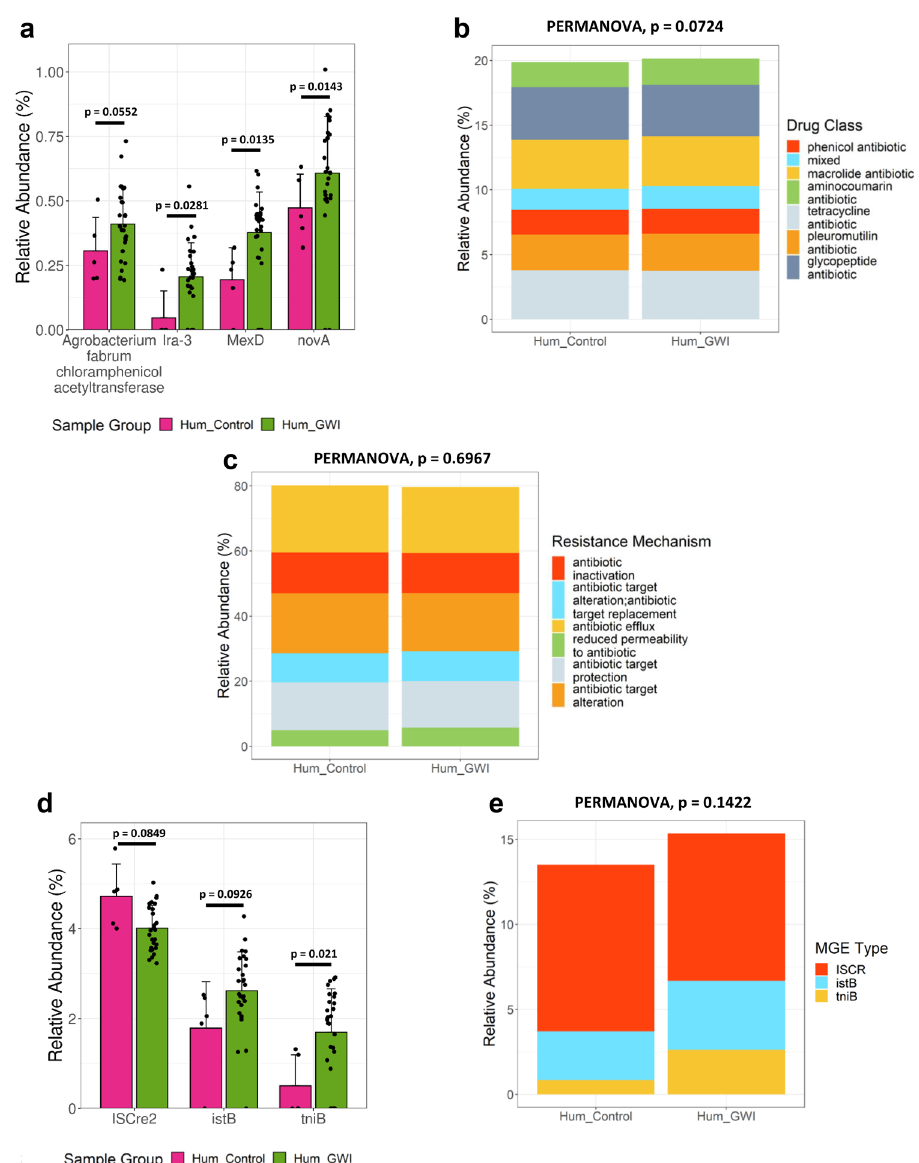
Fig. 4 Classi fi cation of selected ARGs and MGEs in GWI Veterans groups. a Grouped bar graph showing relative abundance (%) of selected ARGs in Hum_Control (Veteran group without GWI symptom, n = 5 biologically independent samples) and Hum_GWI (Veteran group with GWI symptom, n = 28 biologically independent samples). Stacked bar analysis of relative abundance (%) of b drug classes and c mechanisms of resistance. d Grouped bar graph showing relative abundance (%) of selected MGEs in Hum_Control and Hum_GWI groups. e Stacked bar analysis of relative abundance (%) of MGE types. Data represented as Mean±SD (SD: Standard deviation) for the bar graphs. p -values were determined using Wald ’ s test or PERMANOVA where p < 0.05 was considered statistically signi fi